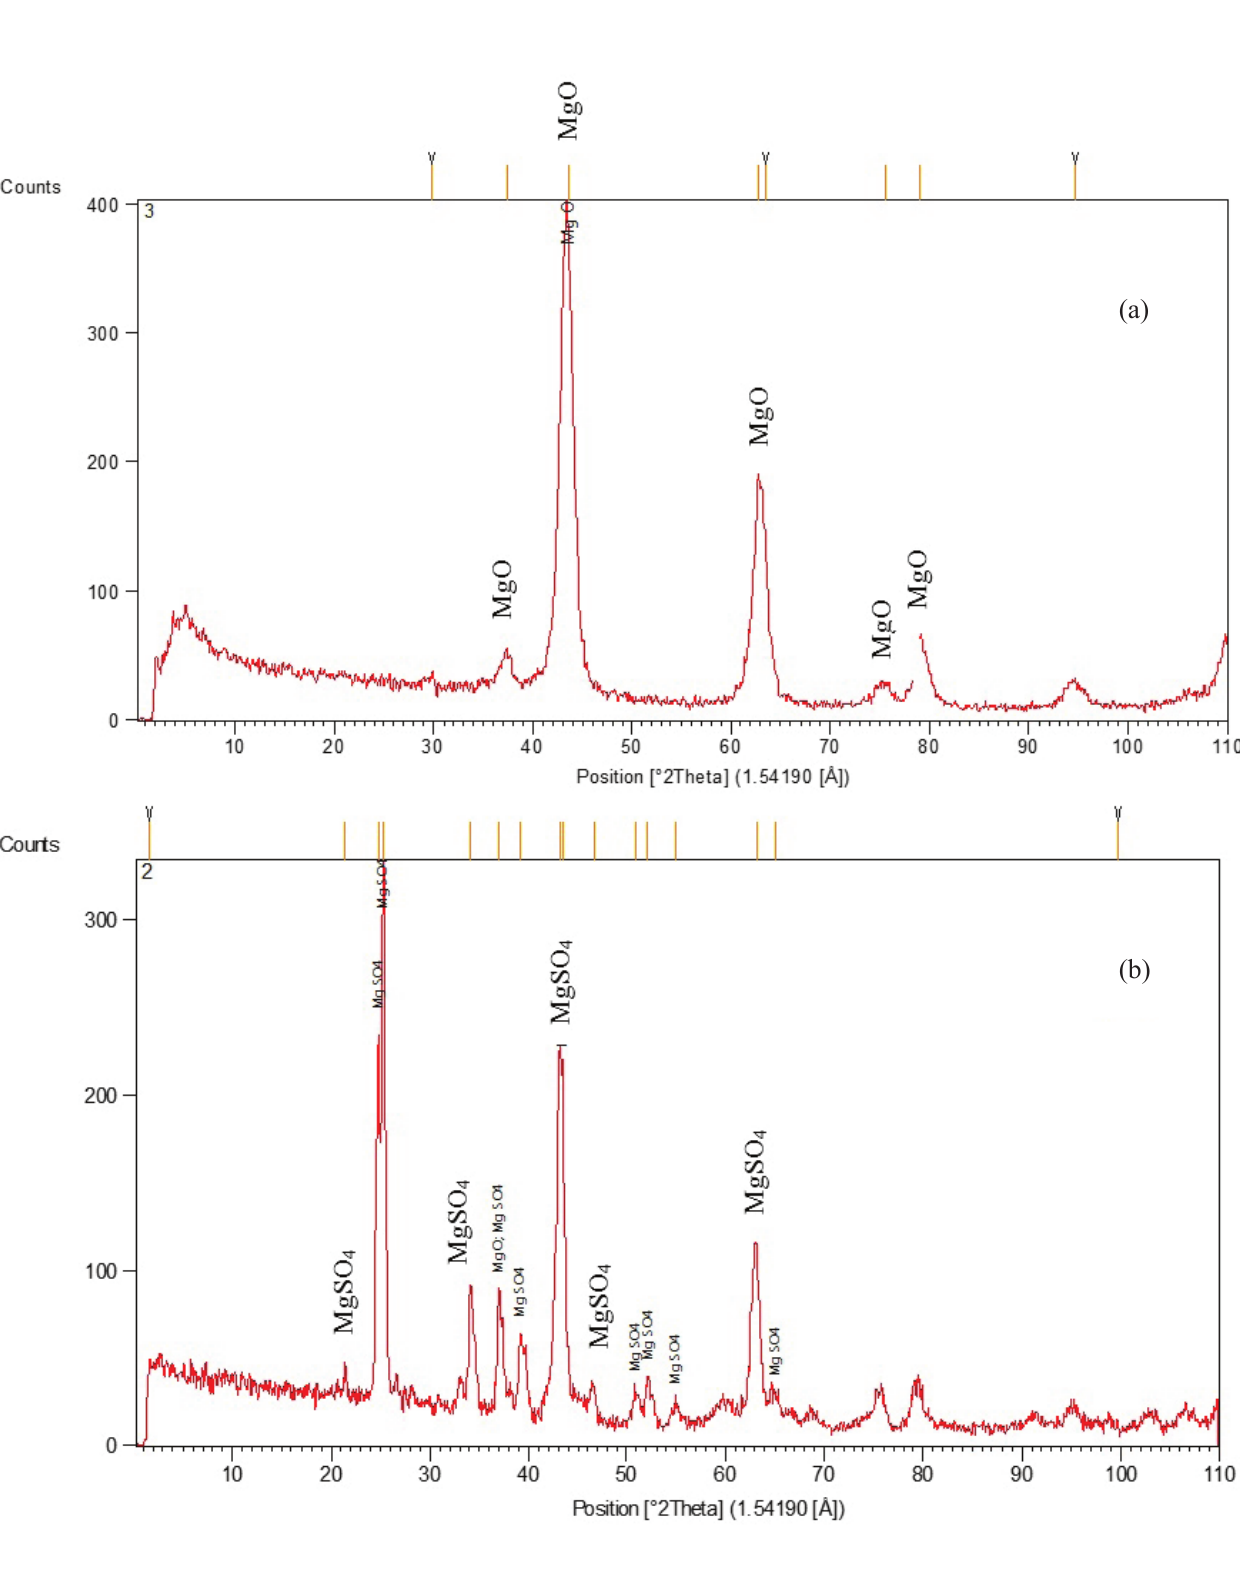
Fig. 7 – XRD analysis of the magnesite sample (a) after calcination process, and (b) after reaction with SO